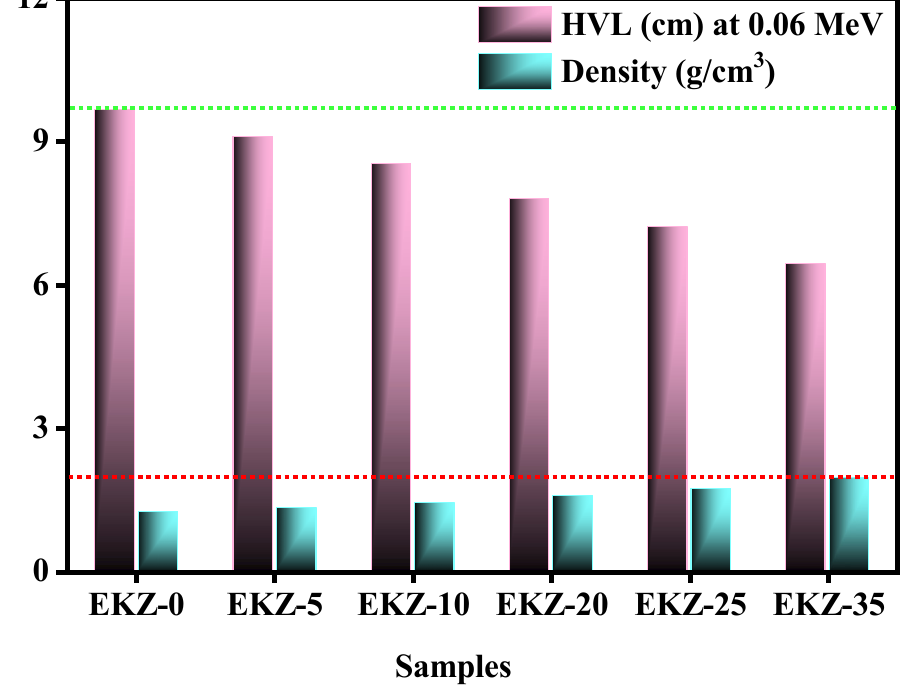
found for sample EKZ-35, while EKZ-5 has given the minimum value of density (1.24